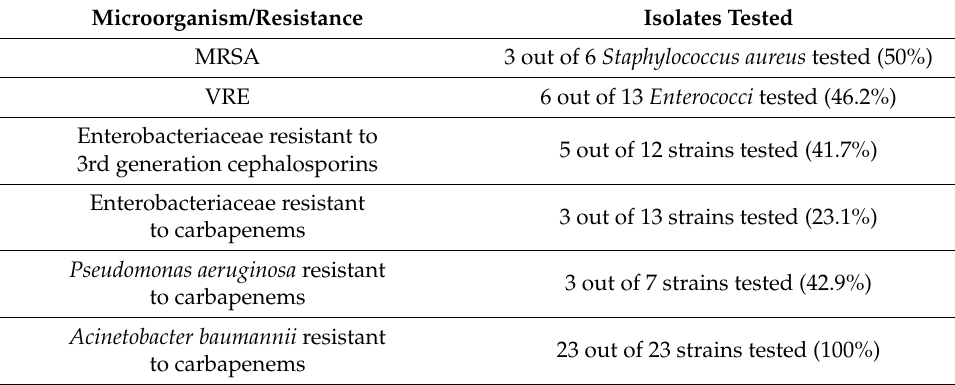
Table 3. Antimicrobial resistance data among strains with available data isolated from patients with hospital-acquired